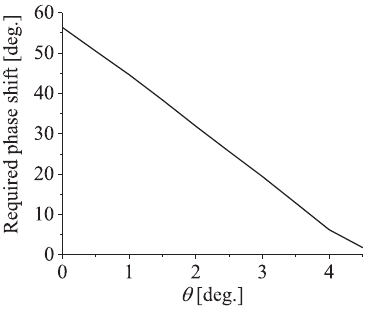
Fig. 4. Required maximum phase shift for 1.5GHz to equalize the directivities toward vertical angle u .